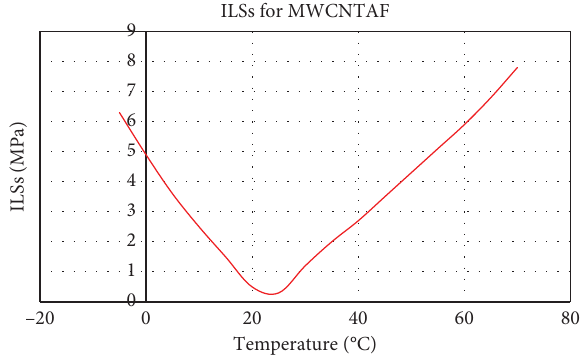
Figure 5: ILSs within the interfaces between MWCNT and AF at temperature range of − 5 to 70 ° C within the